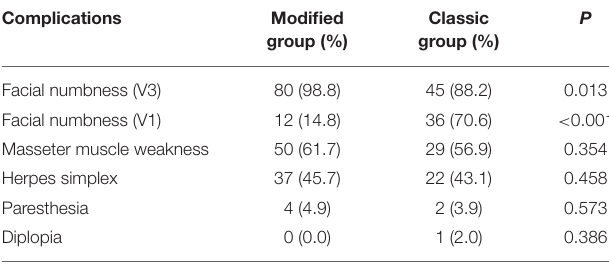
the trigeminal nerve (V1) was significantly lower in the modified TABLE 2 | The complications of the two